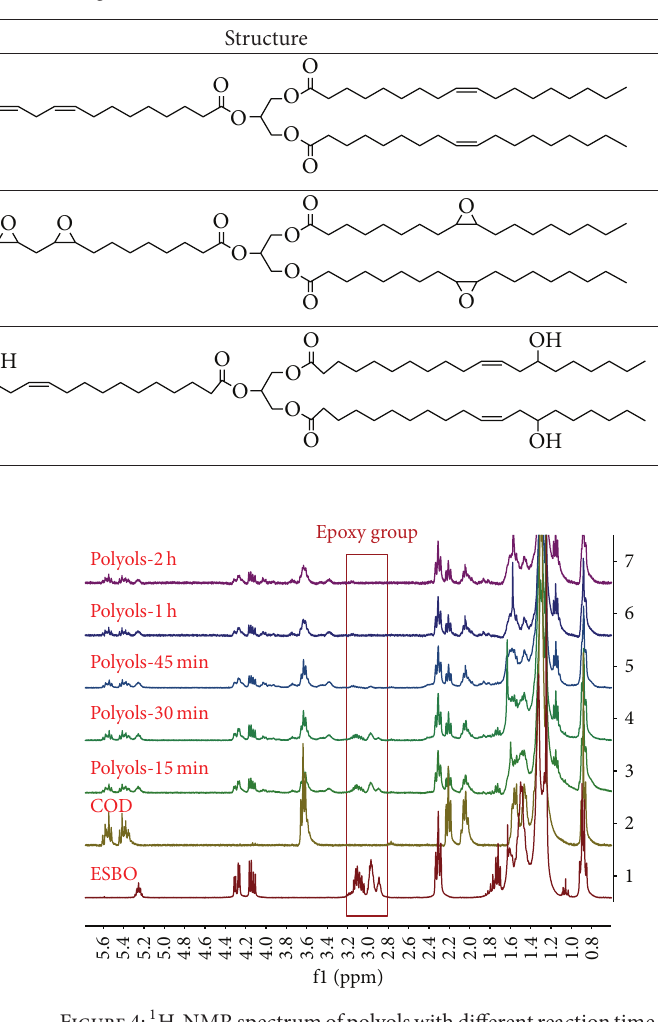
Table 2: Three classic vegetable oils.